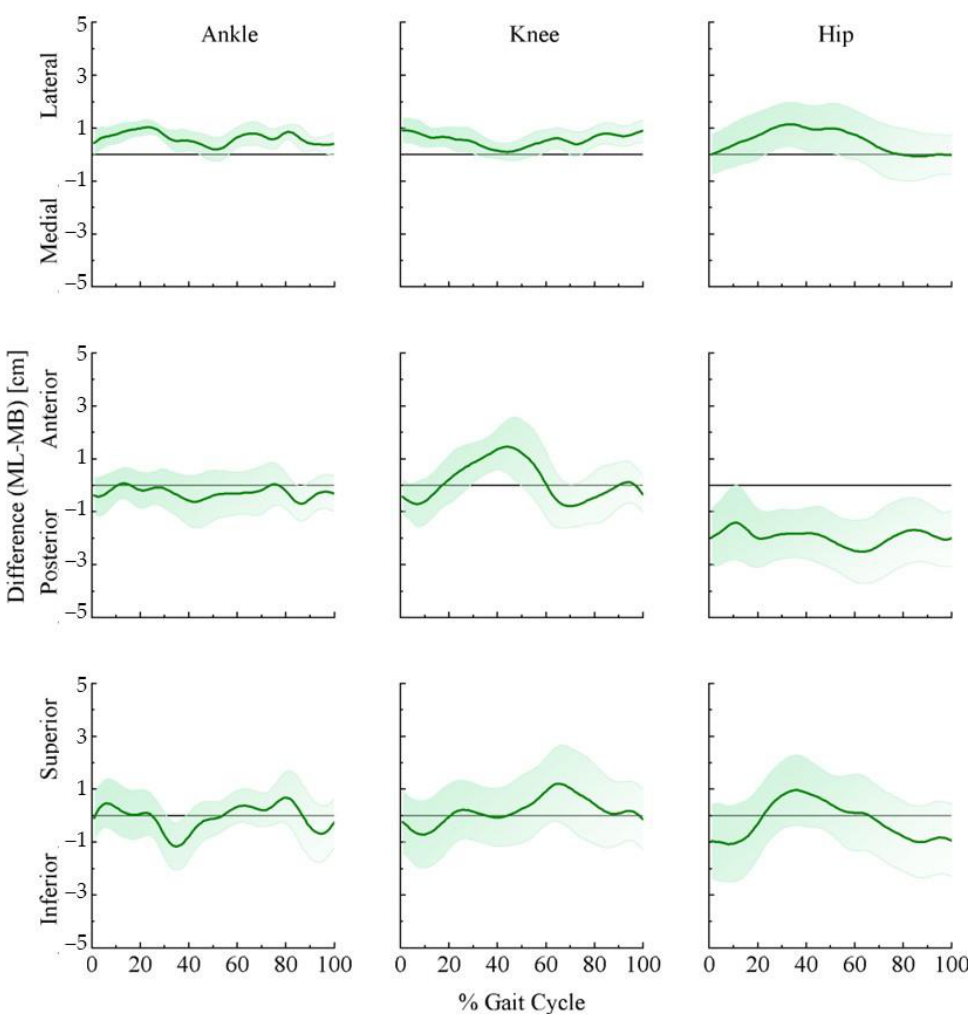
Figure 3. Ensemble curve of lower extremity joint position differences between marker-based and markerless motion capture systems across the average 10 stride cycles for 16 participants. Differences were estimated as markerless (ML) joint center position—marker-based (MB) joint center po- sition.